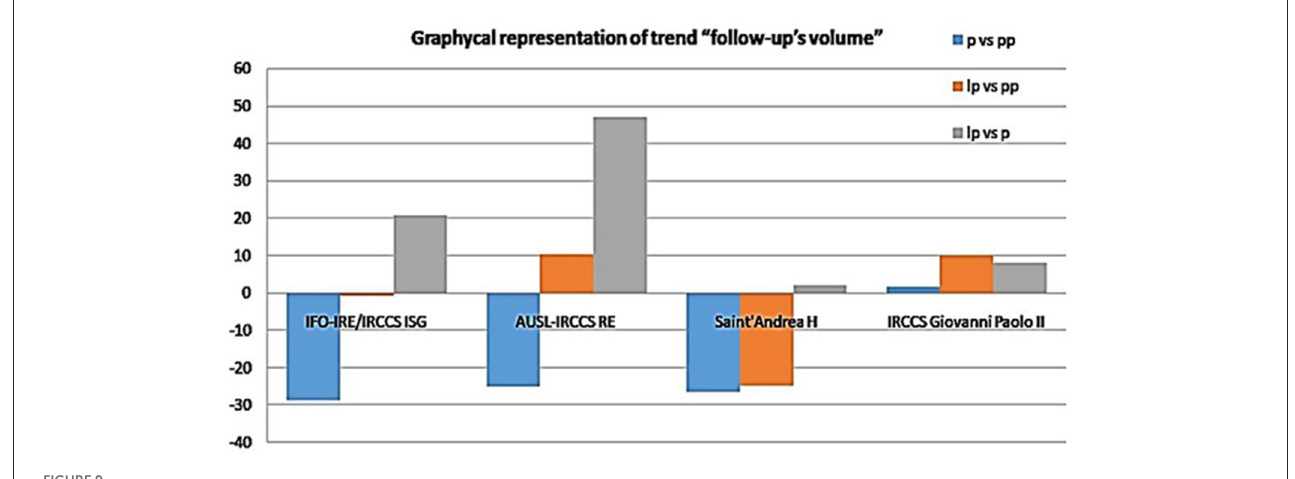
FIGURE9 Volume of follow-up visits over